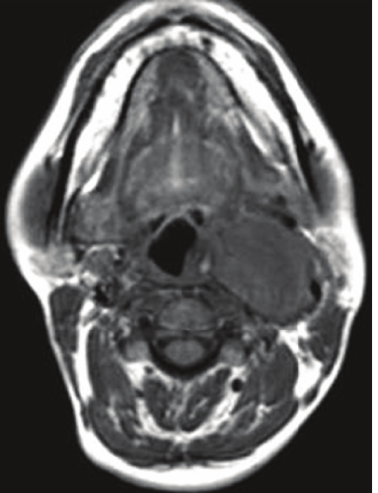
Figure 4: T1-weighted MR image reveals isointense mass on the left carotid space.